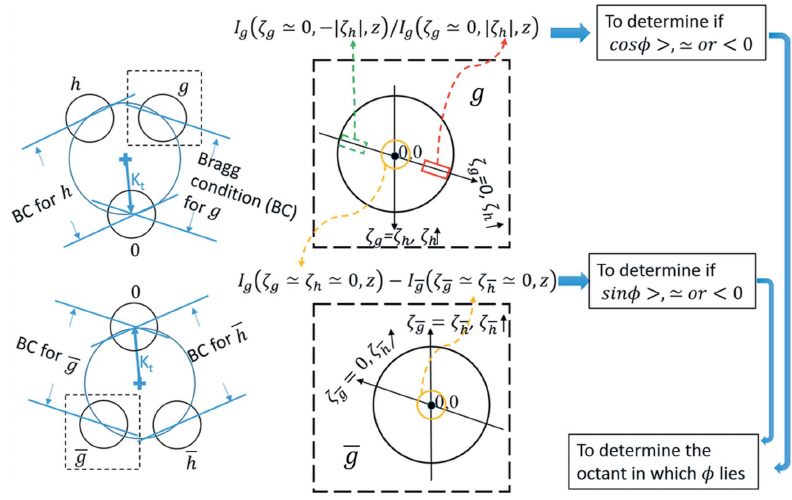
Figure 1 The schematic of a pair of three-beam CBED patterns that involve two Friedel pairs, g and g , and h and h , which are used to determine the octant of the three-phase invariant (the uncertainty of the phase measurement is (cid:2) 22.5 (cid:3) ). The pair of three-beam CBED patterns share the same zone axis that is perpendicular to the plane (and we define it as the ZOLZ plane) formed by the reciprocal lattice vectors g , h , (cid:4) g and (cid:4) h , but have different Laue circles, where the projections of the incident wavevector onto the ZOLZ plane, K t (pointing from the centre of Laue circle to a point of interest in the central ¼ (cid:5) ¼ 0 are labelled, and the intersection is the exact three-beam disc), are in opposite directions. In the magnified view of disc g , two loci, (cid:5) and (cid:5) g h g ¼ 0 ; (cid:5) ¼ 0). Different parts in the three-beam CBED patterns which are marked with circles and rectangles are compared in order to condition ( (cid:5) g h determine the signs of sin (cid:2) and cos (cid:2) . These, together with whether sin (cid:2) (or cos (cid:2) ) is zero, can be used to constrain the three-phase invariants to within an octant ( i.e. (cid:2) 22.5 (cid:3) ).